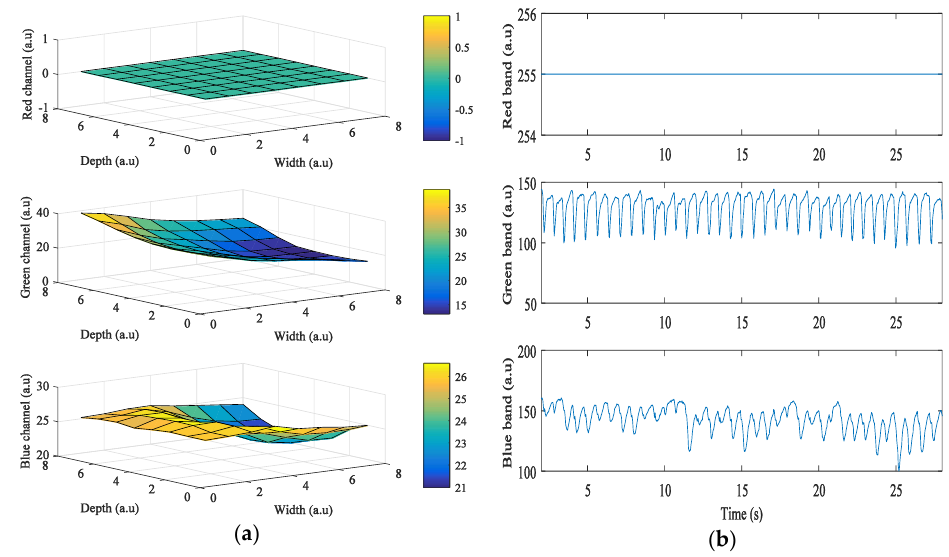
Figure 2. Example of quality analysis of PPG signals obtained from a subject using the Galaxy S6: ( a ) intensity change distribution; ( b ) intensity of PPG signal.